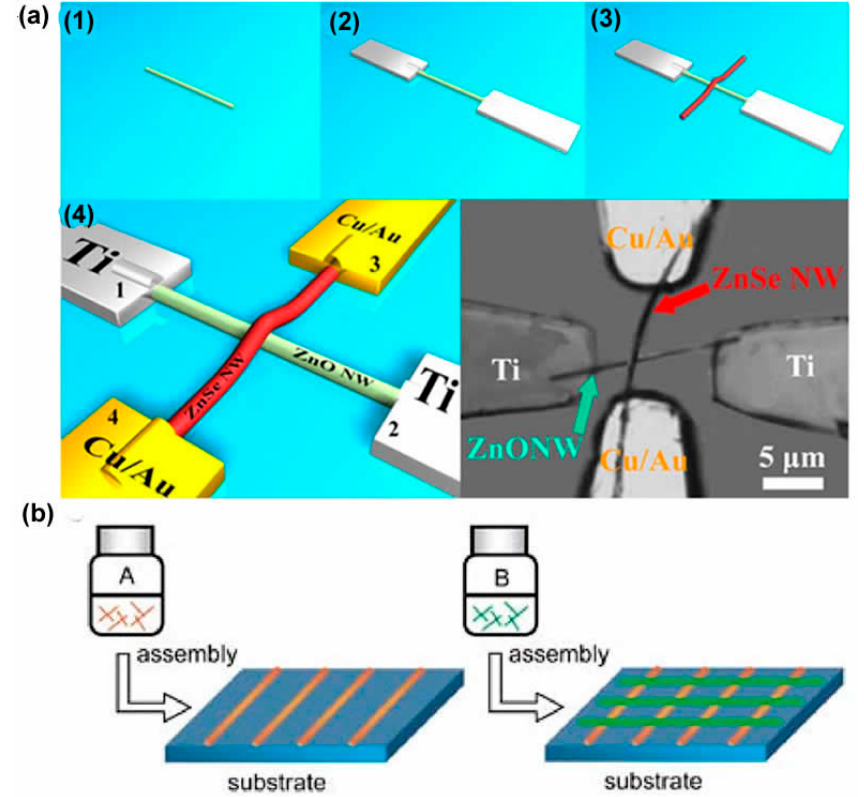
Figure 7. ( a ) Schematic illustration of the step-wise process for the fabrication of a ZnSe nanowire/ZnO nanowire p-n junction and a typical SEM image of the p-n junction device. Reproduced with permission from [43], Copyright 2013, Institute of Physics. ( b ) Schematic of the assembly of crossed nanowire heterojunctions. First, a parallel array of A NWs (orange lines) is aligned on the substrate using a fluidic assembly method, and then a second parallel array of B NWs (green lines) is deposited orthogonally to achieve a crossed NW matrix. Reproduced with permission from [42], Copyright 2005, Wiley-VCH.